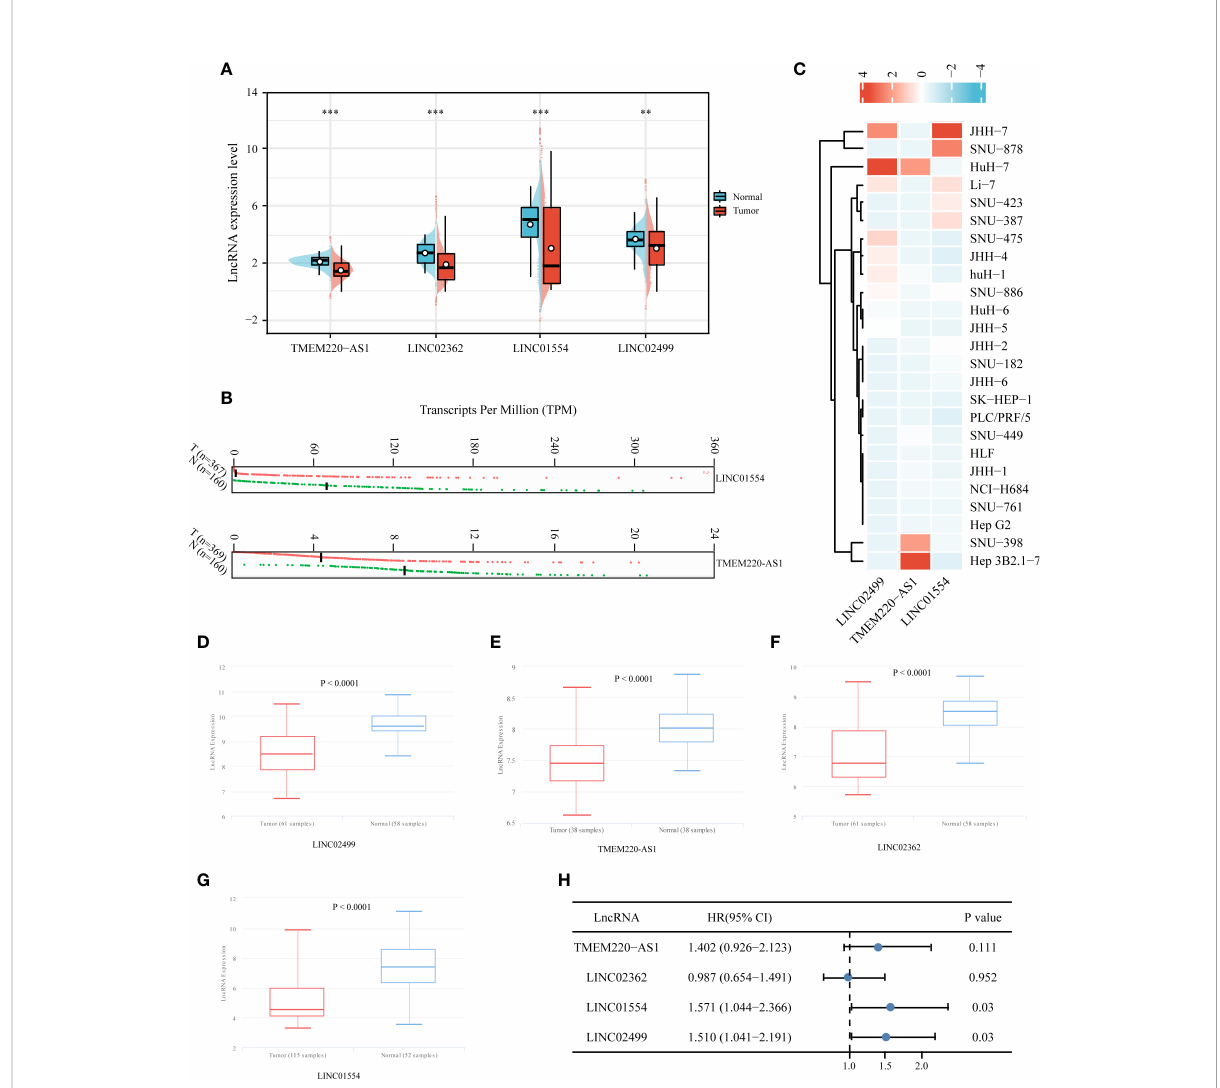
FIGURE 10 Expression validation and independent prognostic analysis of four IICDLs. IICDL expression in HCC tumor tissues and healthy tissues according to TCGA (A) and GEPIA (B) databases. (C) IICDL expression in HCC cell lines according to the CCLE database. (D – G) IICDL expression in HCC tumor tissues and normal tissues according to the lnCAR database. (H) Multivariate Cox regression analysis of the four IICDLs for prognosis prediction of patients with HCC. (**P < 0.01; ***P < 0.001; ns, not signi fi